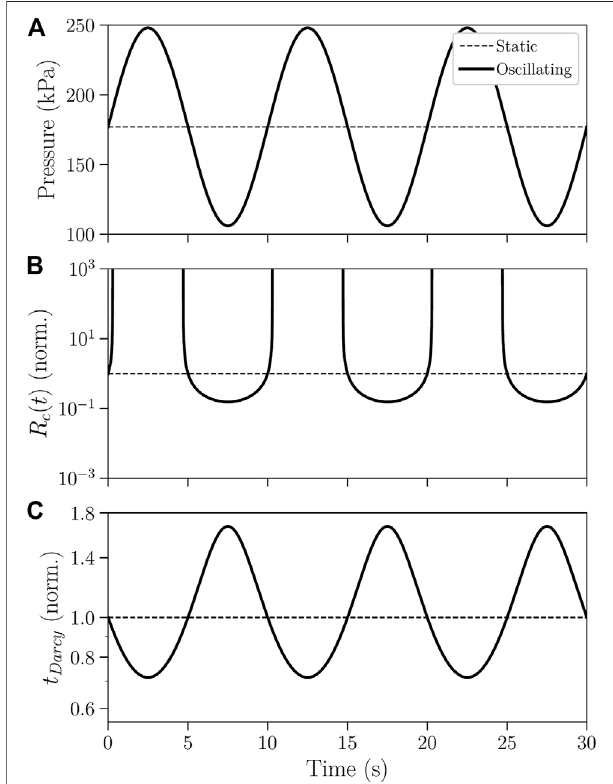
FIGURE 9 | (A) Pressure, (B) critical radius for bubble nucleation R c ( t ) ( Eq. 6 ) and (C) time to evacuate a half-bubble via permeable fl ow t Darcy ( Eq. 10 ) as a function of time during an oscillating experiment (three oscillation cyclesareshown). R c ( t ) and t Darcy arebothnormalized tothestaticcase value (shown as horizontal dashed lines), and plotted on a logarithmic